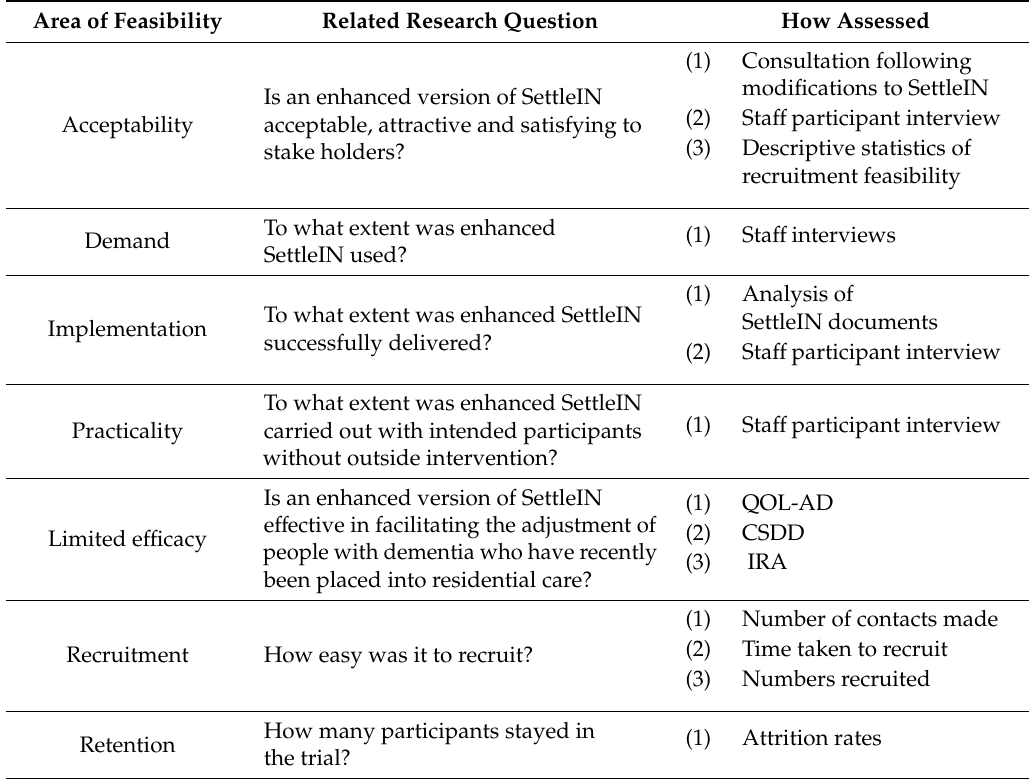
Table 4. Key dimensions of feasibility examined and outcomes measuring